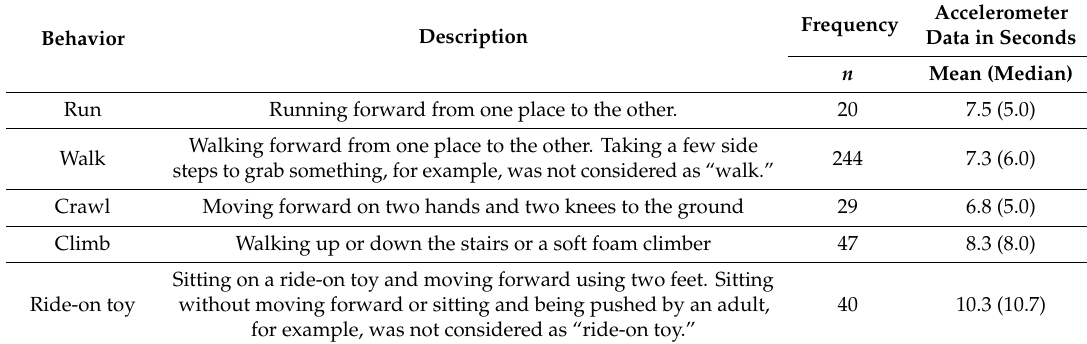
Table 1. Description of behavior and accelerometer data included for